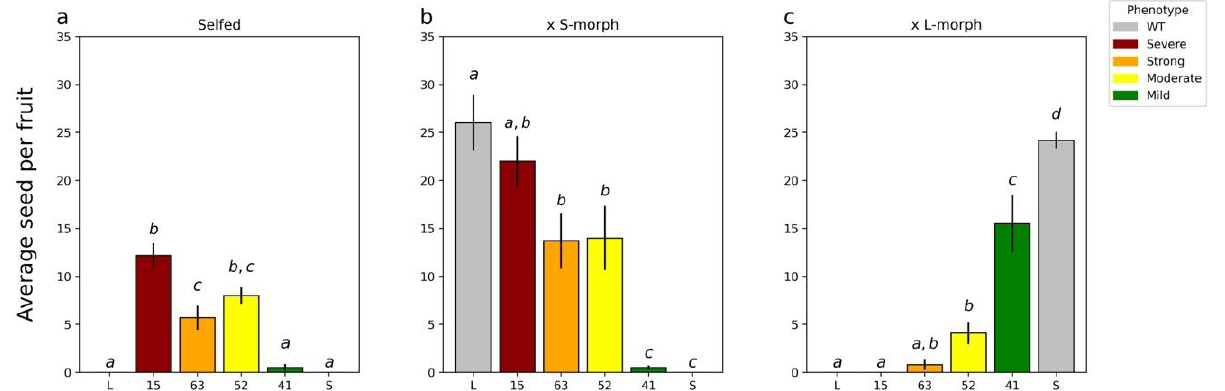
Figure 2. Seed set of T0 plants when self-pollinated and when acting as the pollen donor crossed with WT L- and S-morph plants. ( a ), self-pollination of T 0 plants; ( b ), T 0 plants crossed as male parent to wild type S-morph; ( c ), T 0 plants crossed as male parent to L-morph plants. For all analyses means sharing the same letter are not significantly different following a single factor ANOVA and Tukey’s test. For seed set data, the square root transformation was applied prior to conducting the analysis of variance. Each cross was analyzed independently of the other crosses allowing for comparison of performance within a class. When selfed F 5,54 = 53.2, p < 0.0001; when crossed with S-morph ( × S) F 5,54 = 23.9, p < 0.0001; and when crossed with L-morph ( × L) F 5,54 = 43.7, p < 0.0001. Error bars represent the standard error. N = 10 pollinations.